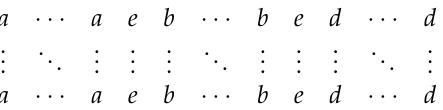
Figure 3. A picture array generated by Π 2